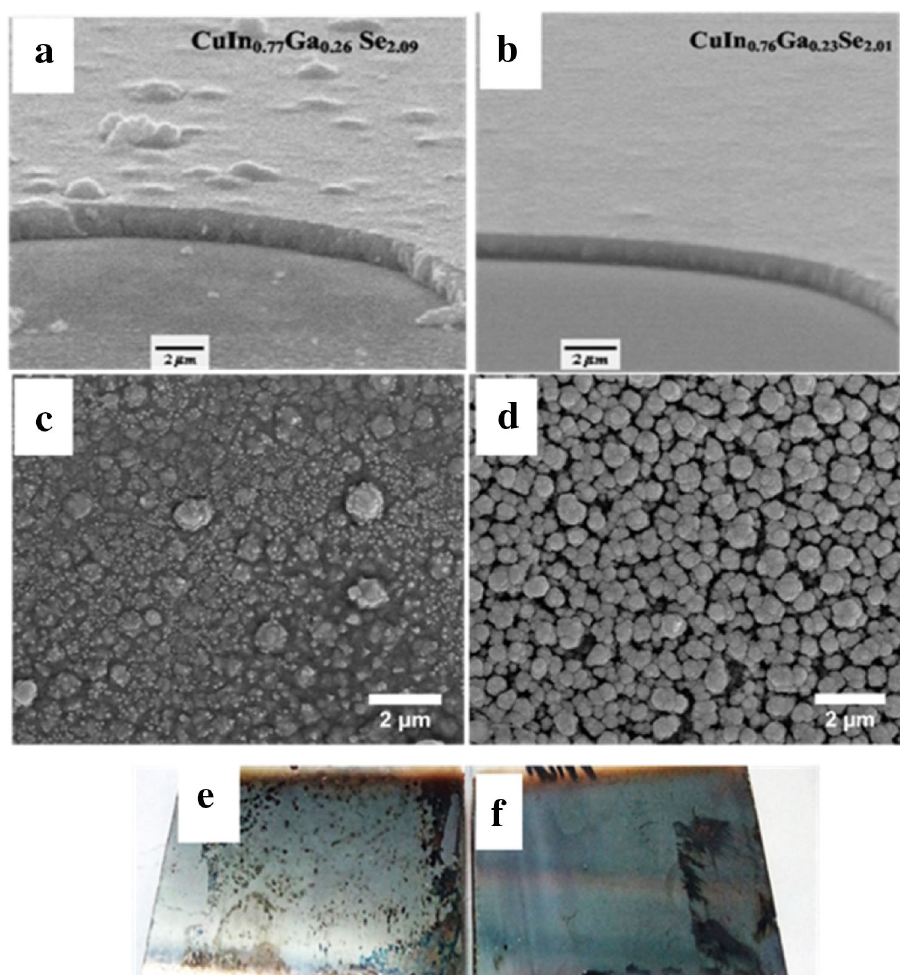
Fig. 7 a SEM cross section of CIGSe electrodeposition without ( a ) and with PT ( b ), FE-SEM of CISe electrodepos- ited without pre-treatment, photographic image ( c , e ) and ( d , f ) with pre-treatment (original work). Reprinted with permission from Calixto et